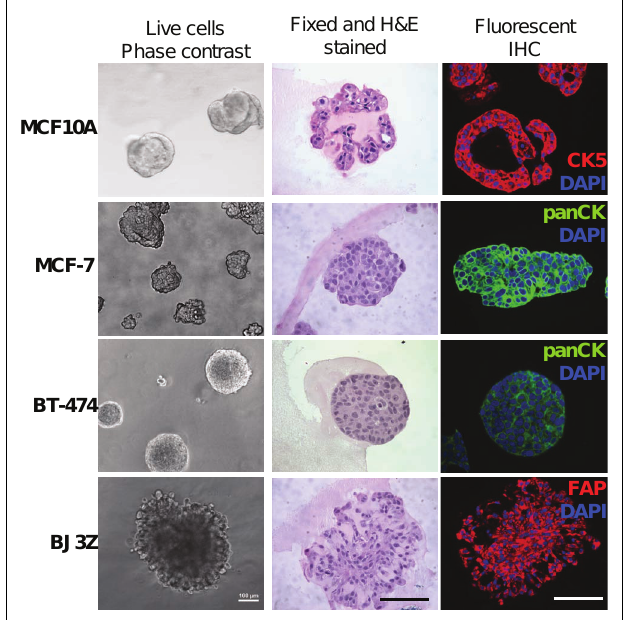
FIGURE 2 | Colonies grown in Matrigel were analyzed by phase contrast, and by H&E and IHC of paraffin-embedded serial sections. MCF10A normal human breast, MCF7, and BT-474 human breast cancer, or BJ3Z activated mouse stromal cells were grown in Matrigel for 7days. Live cells were imaged on day 6 by phase contrast (left). Matrigel/cell blocks were processed on day 7 as described and 5 μ m paraffin sections were stained with H&E (center). For IHC (right), CK5 detected MCF10A cells (red); pan-CK detected the human breast cancer cells (green); fibroblast activation protein (FAP, red) detected the mouse stromal cells. Appropriate red or green fluorescent secondary antibodies were used and sections were counterstained with DAPI (blue). Scale: 100 μ m